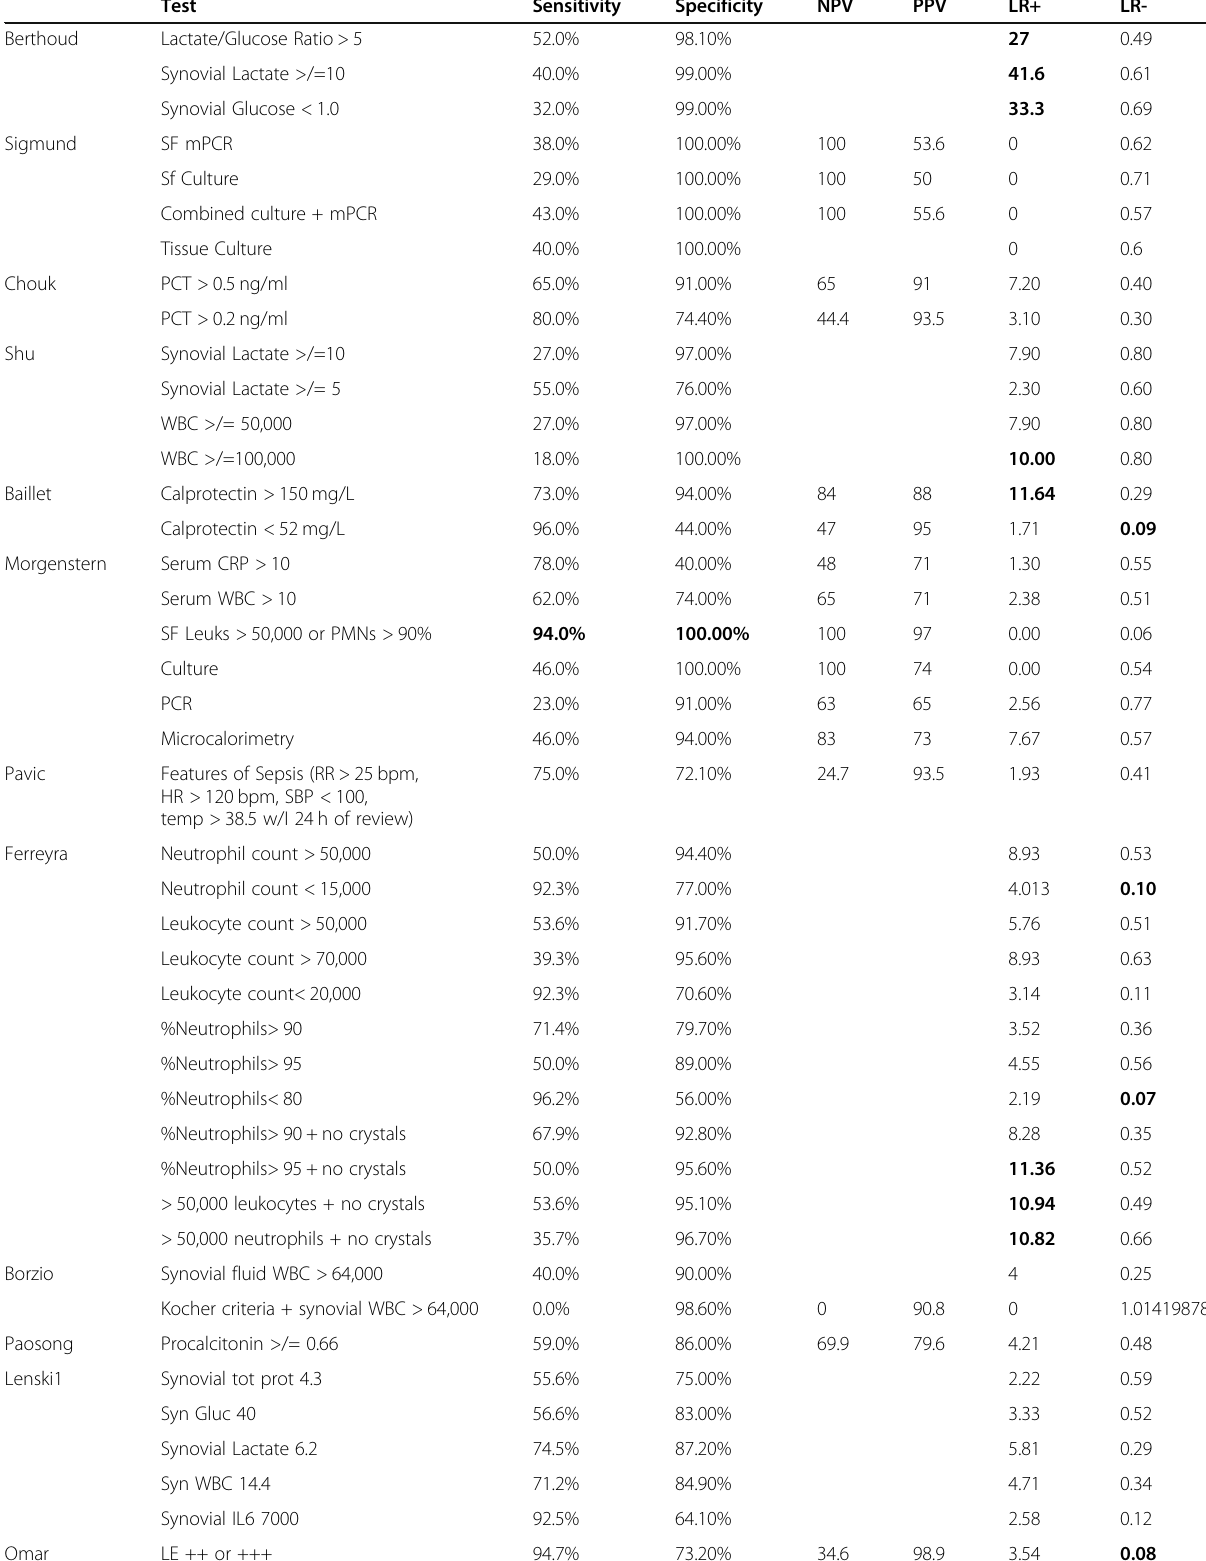
Table 2 Diagnostic Accuracy of Included